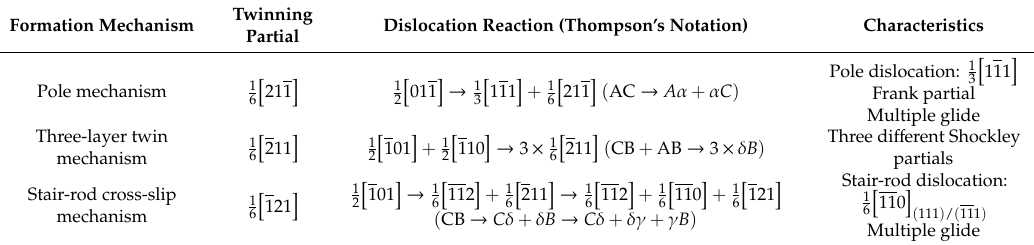
Table 4. Mechanical twin formation